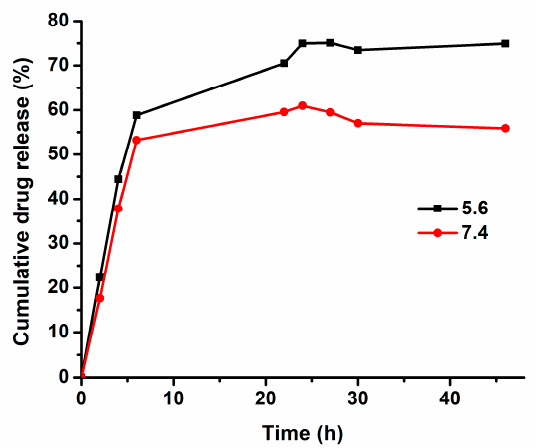
Figure 2. In vitro cumulative release of TPT from polyethylene glycolated niosomes (PEGNIO)/TPT/tLyp-1 at pH 7.4 and 5.6.